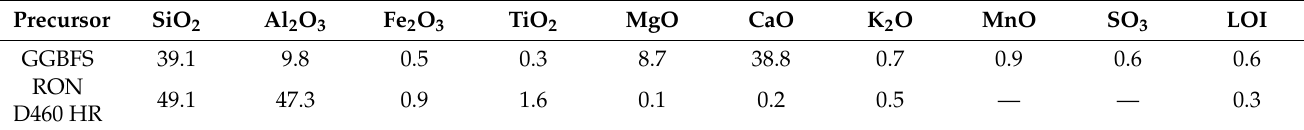
Figure 1. ( a ) Finely ground granulated blast furnace slag (GGBFS); ( b ) metashale (RON D460 HR). Table 1. Chemical composition of the precursors